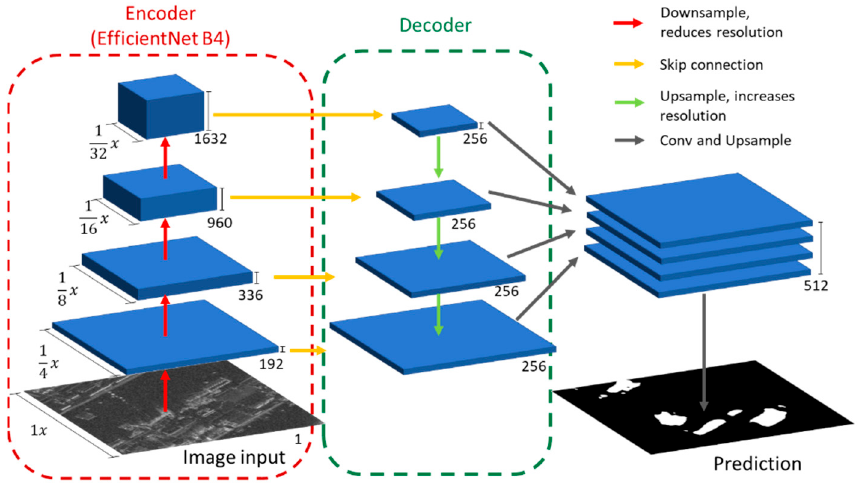
Figure 4. FPN architecture with EfficientNet backbone for segmentation tasks. FPN uses feature pyramids instead. In the Encoder, the image input is scaled down using a dilated convolution operation which cuts the image dimension in half at each pyramid level. As the data flows up the pyramid, the top layer will have the least width and height (the original input’s size divided by 32) but the richest semantic information (1632 feature maps or channels). In a classification task, this is compressed further to output a vector with the same size as the number of classification labels [31]. For a segmentation task, an output with the same spatial size as the input is required. Therefore, the top layer needs to be